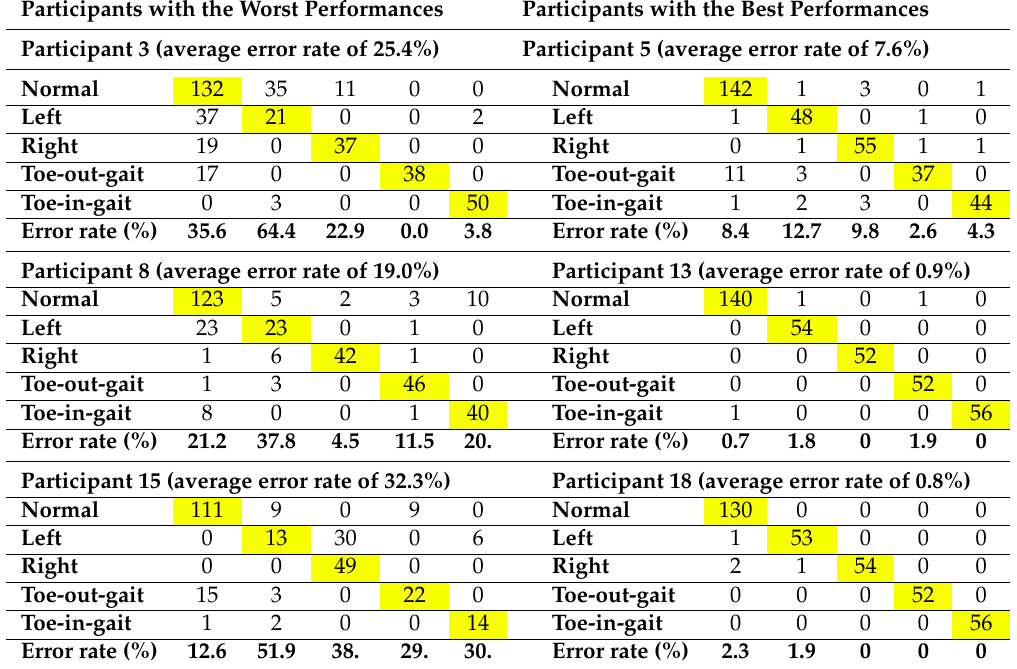
Table 9. The confusion matrix of the worst and the best performances. Participants with the Worst Performances